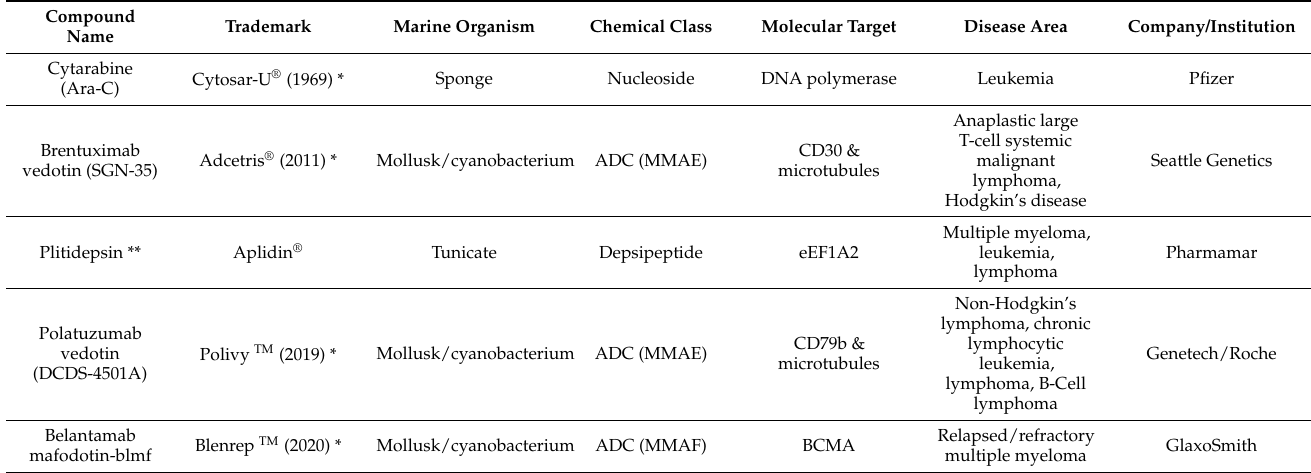
Table 1. Compounds derived from marine organisms and currently on the market. ADC, antibody–drug conjugate; BCMA, B-cell maturation antigen; eEF1A2, translation elongation factor 1A2; MMAE, microtubule inhibitor monomethyl auristatin E; MMAF, microtubule inhibitor monomethyl auristatin F.